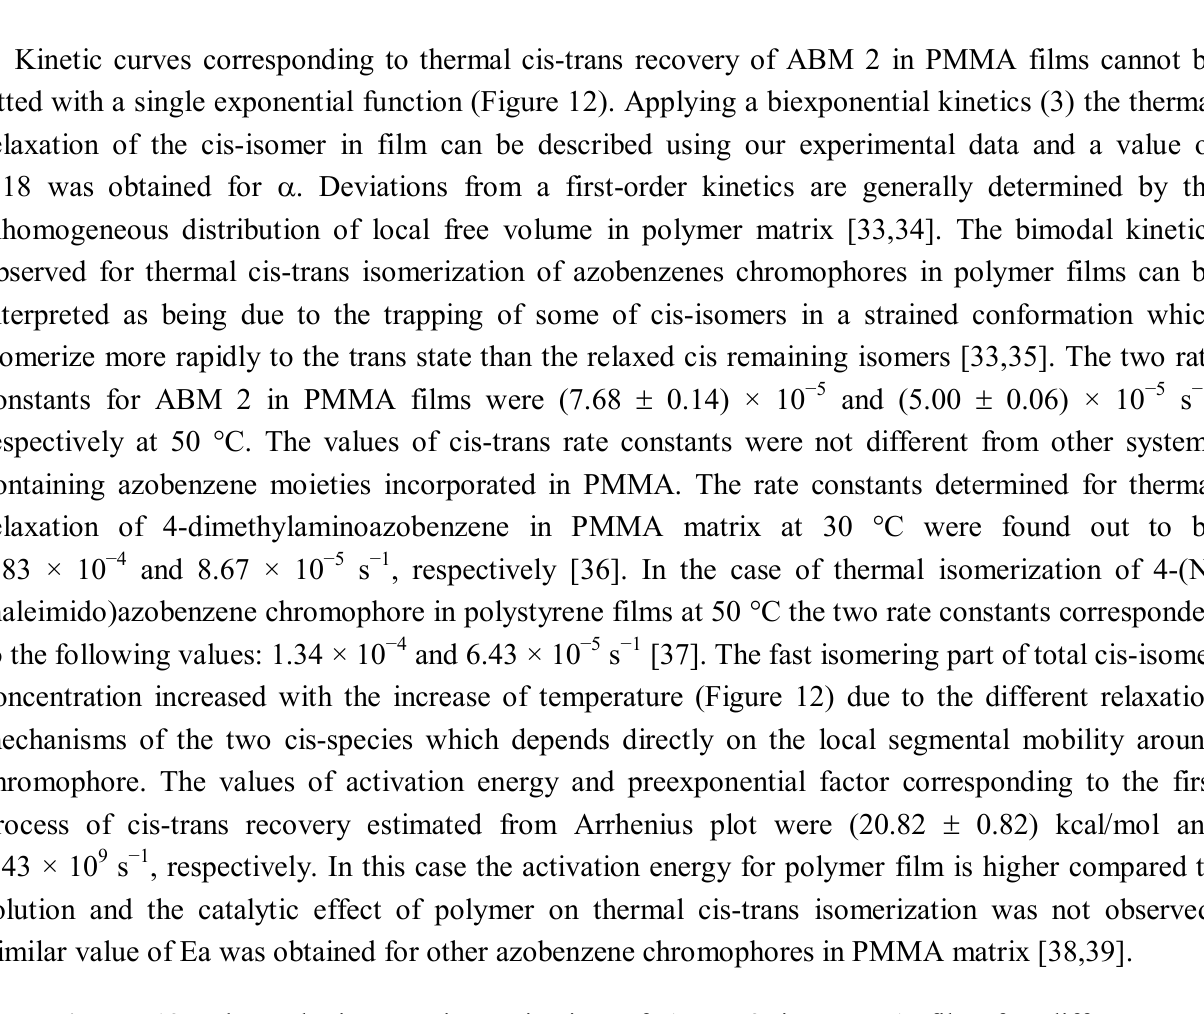
Figure 12. Thermal cis-trans isomerization of ABM 2 in PMMA film for different temperatures: (1) 40 °C; (2) 50 °C; (3) 60 °C; (4) 70 °C; (5) 80